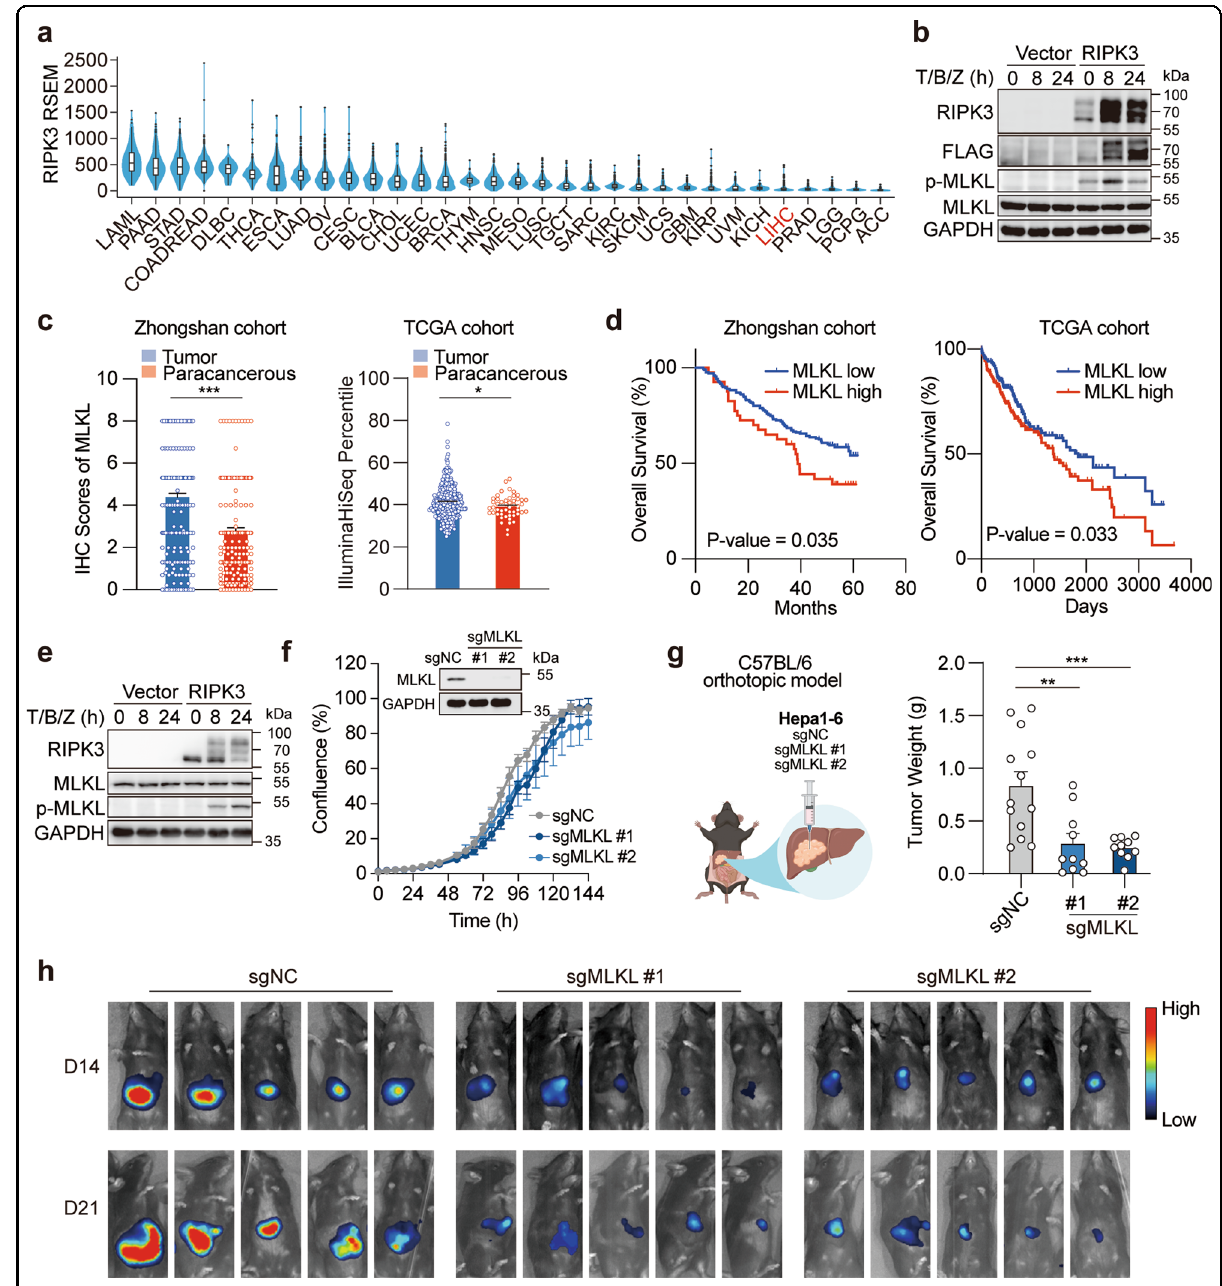
Fig. 1 MLKL de fi ciency impairs the orthotopic growth of HCC tumors. a RIPK3 expression in patient samples across different types of cancer. Data were extracted from TCGA database. b Reconstitution of RIPK3 restores the necroptotic signaling in human HCC cells. HepG2 cells were transfected with the empty vector or pcDNA3.1-hRIPK3-Flag for 24 h and necroptotic signaling was stimulated by 50 μ M Z-VAD-FMK followed by 50 ng/mL TNF α plus 20 μ M Birinapant (T/B/Z). c MLKL expression in cancer tissues and adjacent normal tissues in two independent cohorts of HCC patients. d Survival analysis of MLKL high- and low-expression patients. The same set of data as in c were used for the analysis. e Reconstitution of RIPK3 restores the necroptotic signaling in murine HCC cells. Hepa 1 – 6 cells were treated and analyzed as described in b . f Growth curves of MLKL-KO and control murine HCC cells in vitro. Hepa 1 – 6-luc cells were infected with lentivirus-delivered sgMLKL or negative control (sgNC). KO ef fi ciency was assessed by immunoblotting and cell growth was monitored by the live-cell analysis system IncuCyte ( n = 3). g , h Orthotopic tumor growth of MLKL- KO and control HCC cells in a syngeneic model. Cells as described in f were orthotopically implanted in the liver of C57BL/6 mice ( n = 13 for sgNC; n = 10 for sgMLKL #1 and sgMLKL #2). Tumor growth was monitored by whole-animal imaging. Endpoint tumor weight was shown in g . Representative luminescent images were shown in h . Data are represented as means ± SEM. Two-tailed Student ’ s t -test was used for statistical analysis. ns, not signi fi cant; * P < 0.05, ** P < 0.01, *** P <